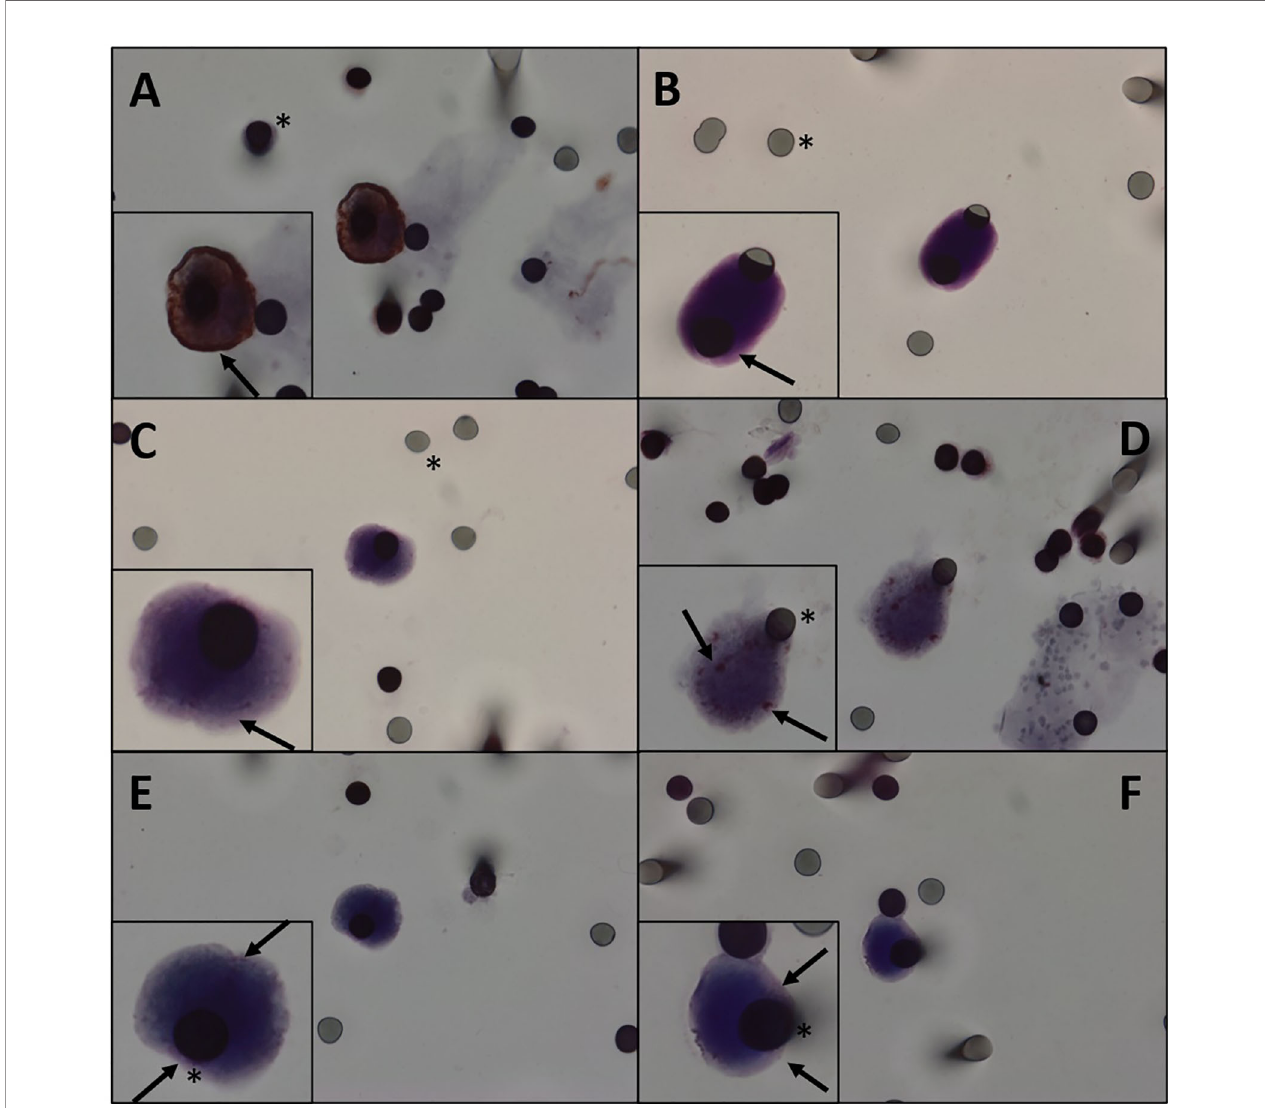
FIGURE 2 | (A) Immunocytochemistry of CTC with b -catenin antibody counterstaining with DAB. (B – F) Immunocytochemistry of CTC with b -catenin antibody and counterstaining with magenta chromogen. We can observe different degrees of staining. (A, B) b -Catenin highly positive staining in a patient. (C, D) b -Catenin middle staining in a patient. (E, F) b -Catenin weakly positive staining in a patient. Black asterisk: membrane spots. Black arrows: b -catenin. CTC, circulating tumor